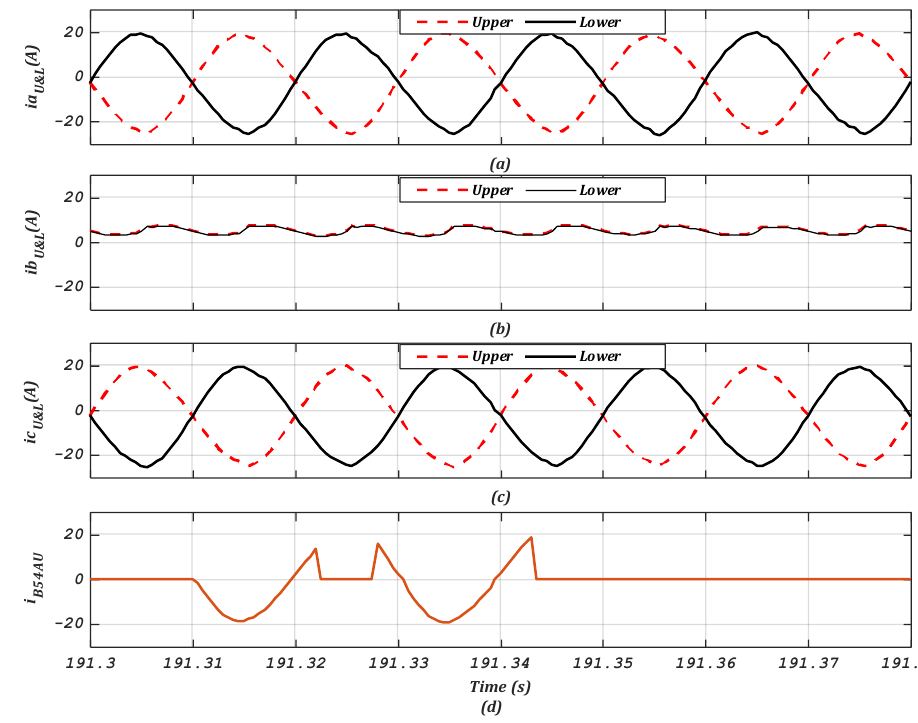
Figure 11. Arm currents ( a ) in phase A, ( b ) in phase B, ( c ) in phase C, and ( d ) current of battery 54 in the phase A upper arm.